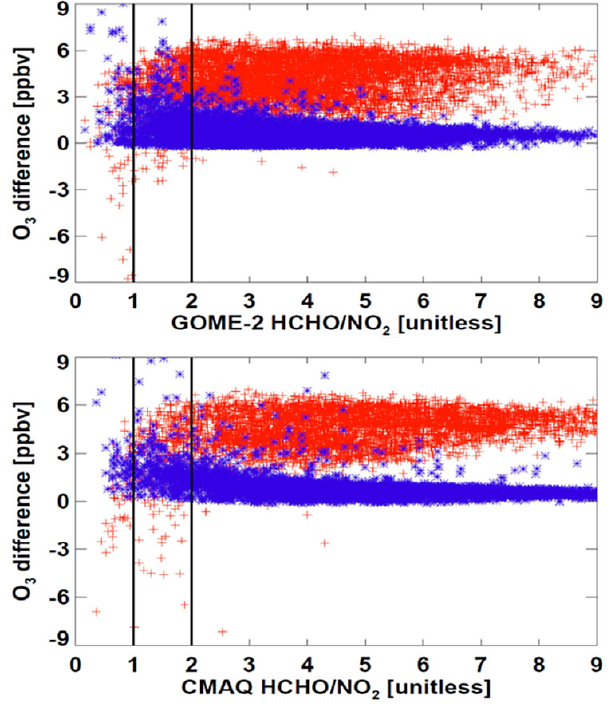
Fig. 2. Differences between the surface O 3 in the baseline CMAQ and that in CMAQ with 30% NO x reduction (in red, baseline – sensitivity) or a reduction in VOC emissions (in blue, baseline – sensitivity) in accordance with the ratios of the GOME-2 HCHO to NO 2 column density (upper panel) and the CMAQ HCHO to NO 2 column density (lower panel). The differences are estimated by averaging the data for the daytime (01:00–05:00p.m., local time) during August 2009 only when GOME-2 NO 2 or the CMAQ NO 2 column density is larger than 1.0 × 10 15 moleculescm − 2 . So that the trend can be more clearly observable, all five O 3 differences are averaged according to the GOME-2 or CMAQ